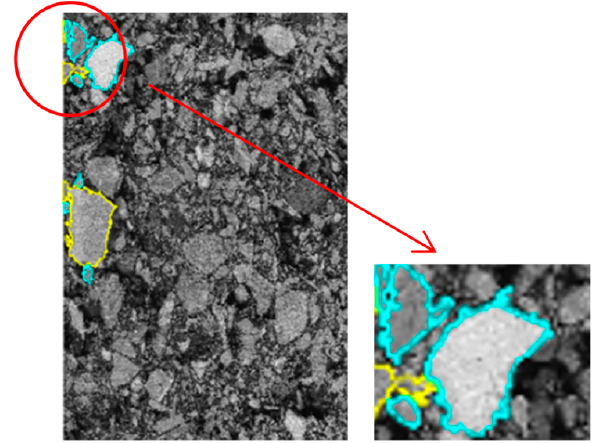
Figure 4. The processing in IPAS program with an example of contact lines.